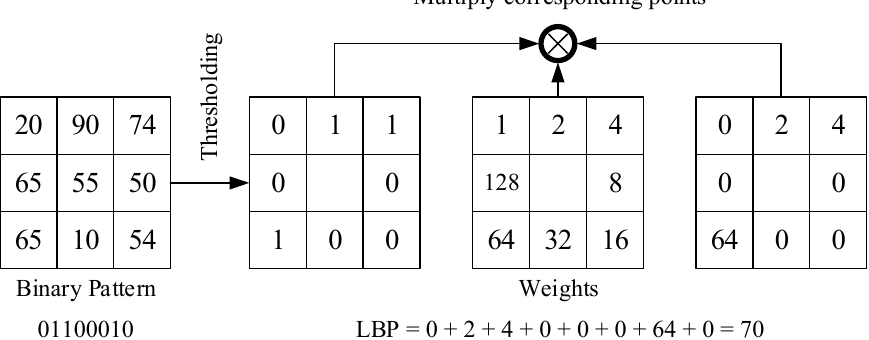
Figure 1. Principle and encoding process of the LBP (Local Binary Pattern).